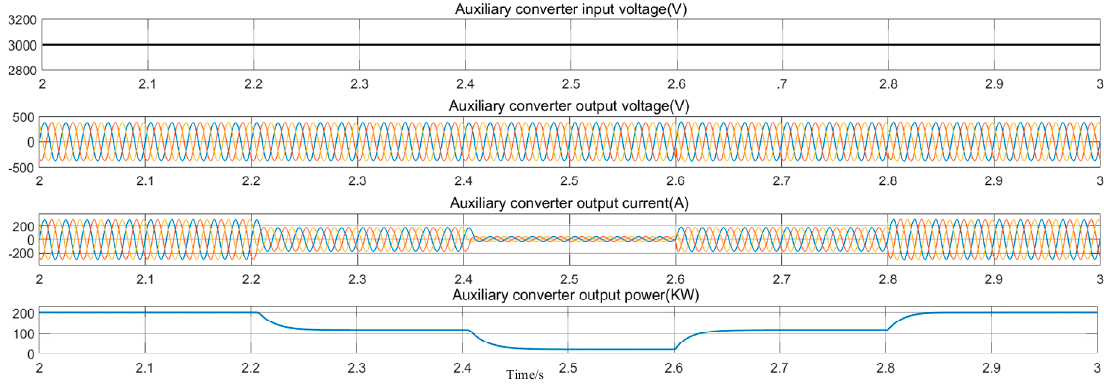
Figure 17. AC bus load switching simulation results.